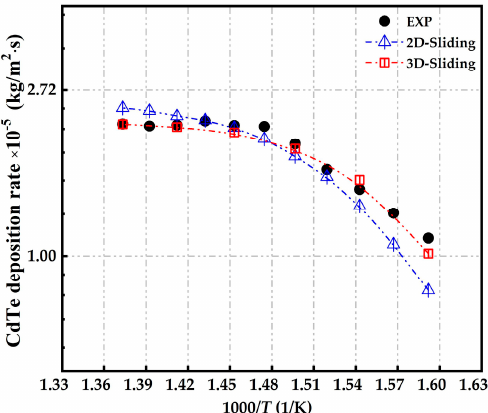
Figure 10. Comparisons of the CdTe deposition rate by using the sliding mesh method as a function of the substrate temperature.